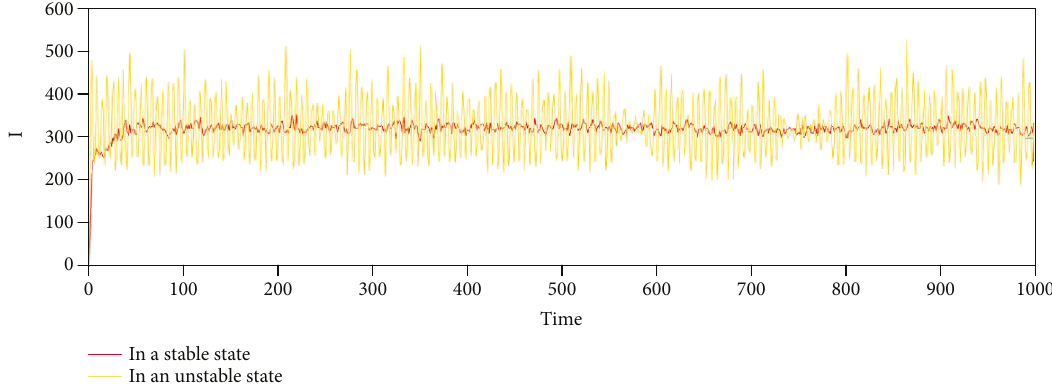
Figure 20: Comparison of initial inventory changes of the warehousing system in a stable state and unstable state under the scenario of random demand obeying normal distribution.